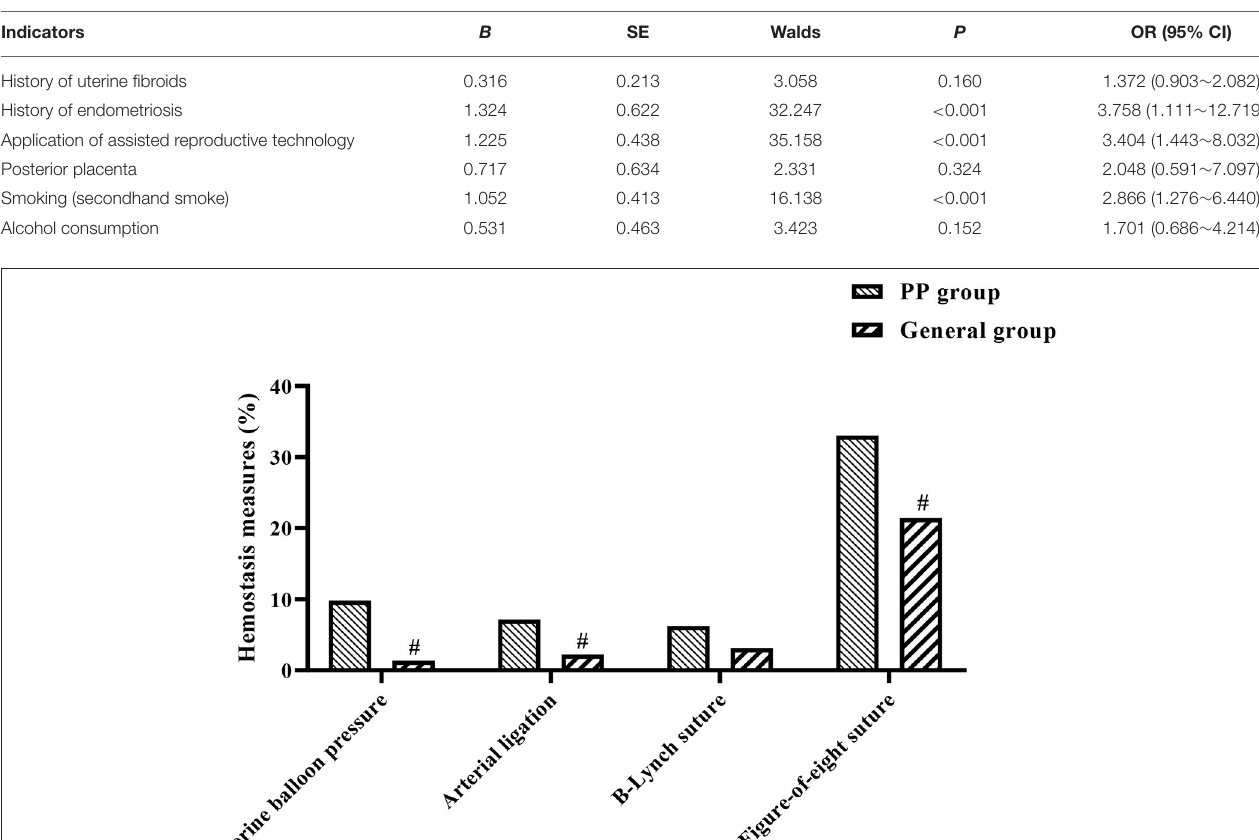
Frontiers in Surgery |